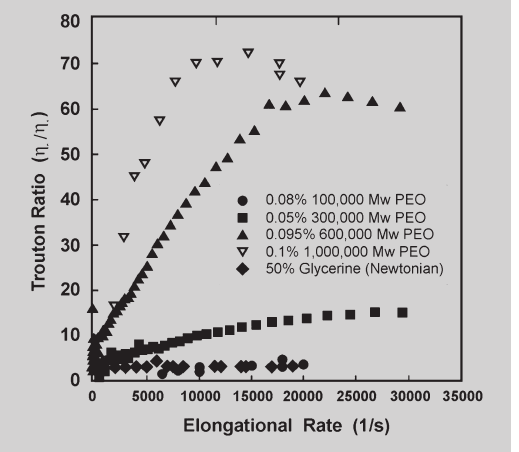
Figure 3 (left): Measurement of the exten- sional viscosity of some rep- resentative constant and equal viscosity polyethylene oxide solutions, as listed in Table 1, with the constant and equal shear viscosities shown in Figure 1. Figure 4: Jet breakup length as a function of jet velocity for low molecular weight PEO